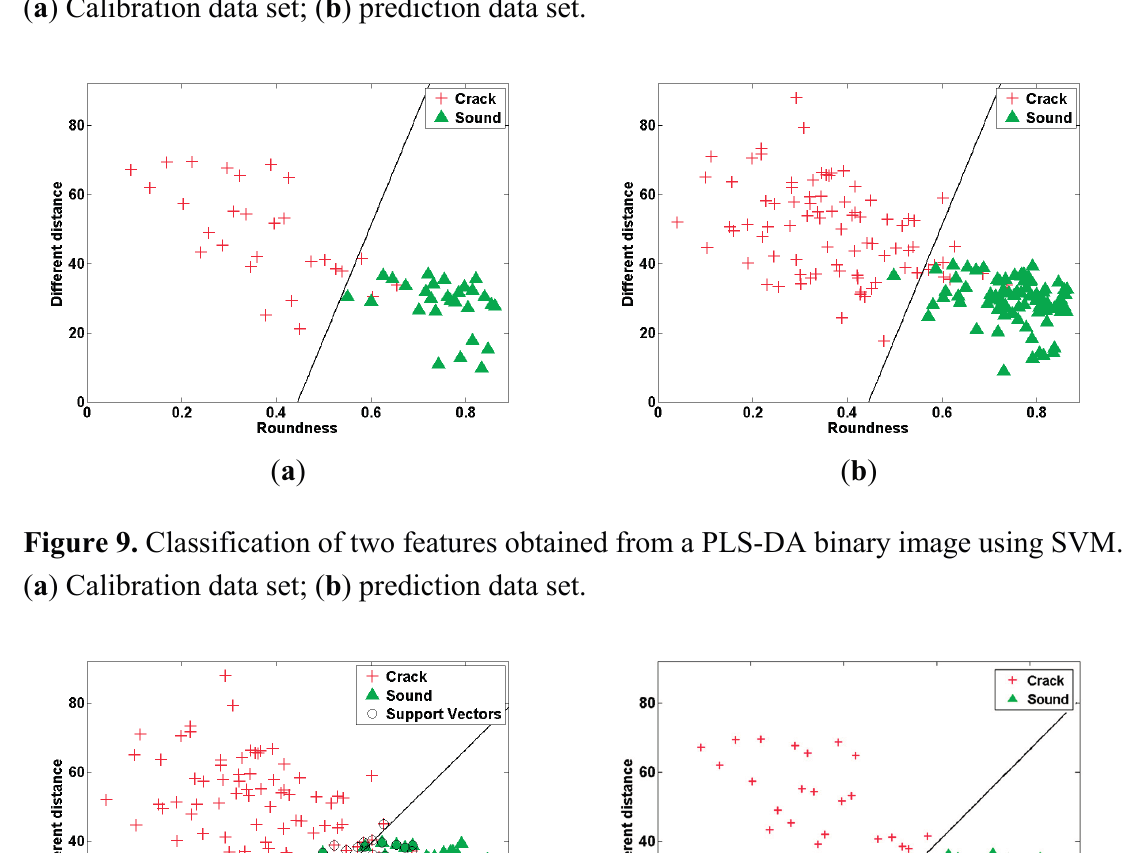
Figure 8. Classification of two features obtained from a PLS-DA binary image using LDA.